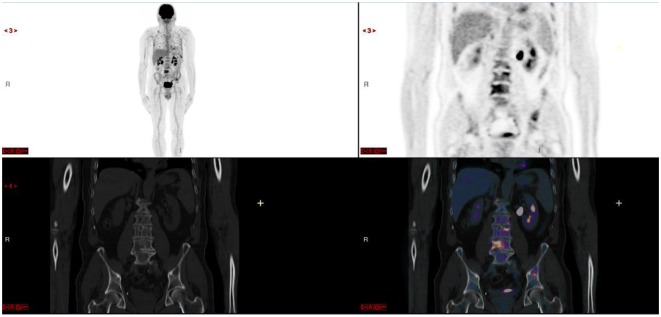
Diffuse medullary involvement (and superimposed lesions).